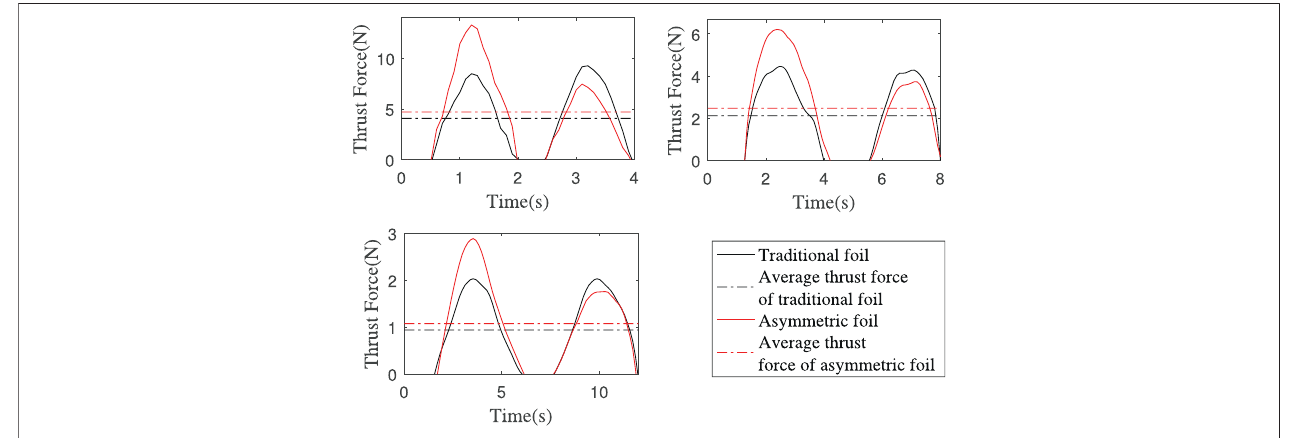
FIGURE 13 | The four reference frames:Earth- fi xed frame ( NED ); Float Frame ( F ); Glider frame ( G ); System frame ( O ). velocity points to the coordinate square axis, and the positive direction of angle and angular velocity follows the right-hand rule. - Roll angle ϕ : The angle between the plane xoz and the plane of the plumb containing the x-axis. According to the right- hand rule, from the vertical plane to the symmetrical plane